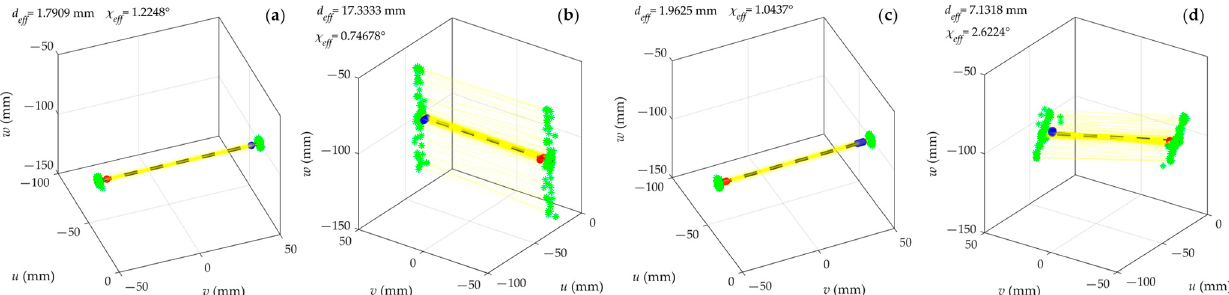
Figure 4. IHA (yellow lines) and MHA (black dashed line) estimation for different motion configu- rations: ( a ) 1 DoF, flexion/extension; ( b ) 2 DoFs, flexion/extension + horizontal displacement; ( c ) 2 DoFs, helical motion; ( d ) 6 DoFs, tri-planar motion. Linear (in mm) and angular (in deg) dispersion parameters are reported in each plot. Lateral and medial tips of the exact AoR are represented in red and blue colors, green points are the intersection of the IHAs with two quasi-sagittal planes orthogonal to v axis and located at ±50 mm from the origin of the shank LCS.